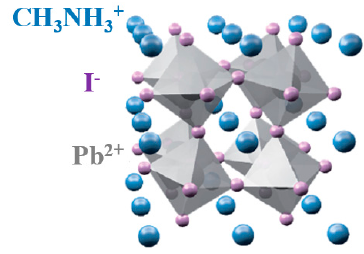
Figure 1. Hybrid organic inorganic perovskite tetragonal structure .